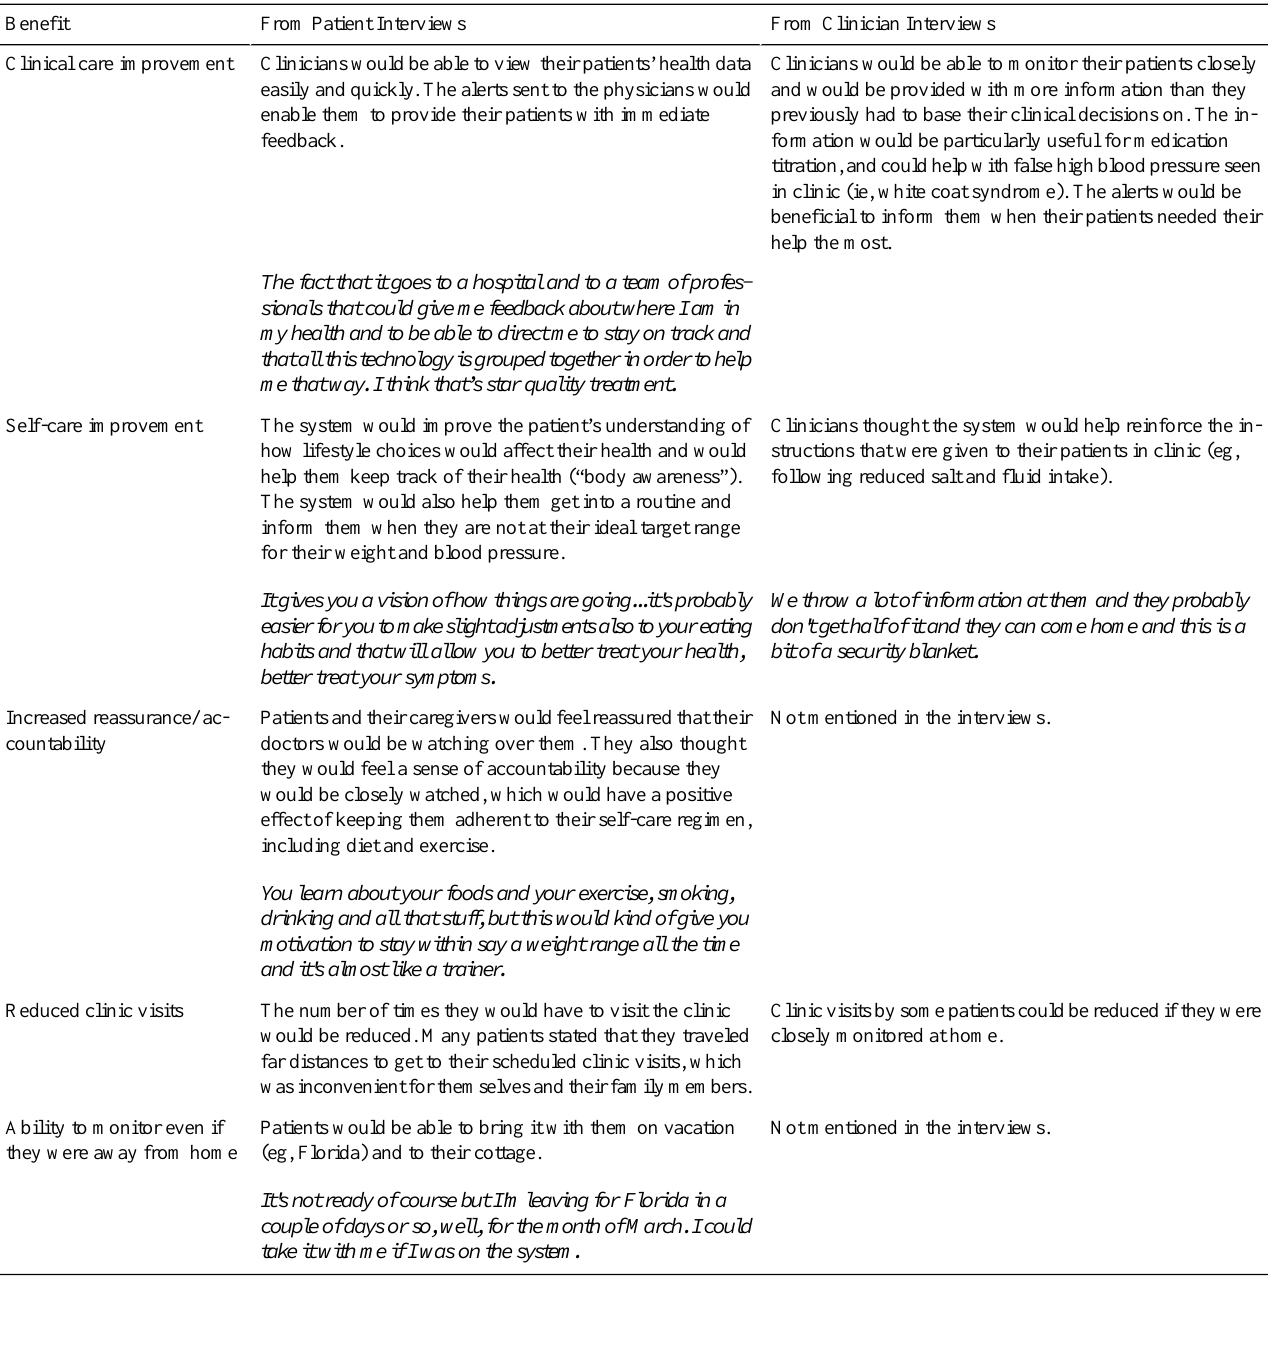
Table 3. Perceived benefits by patients and clinicians (quotes in italics)